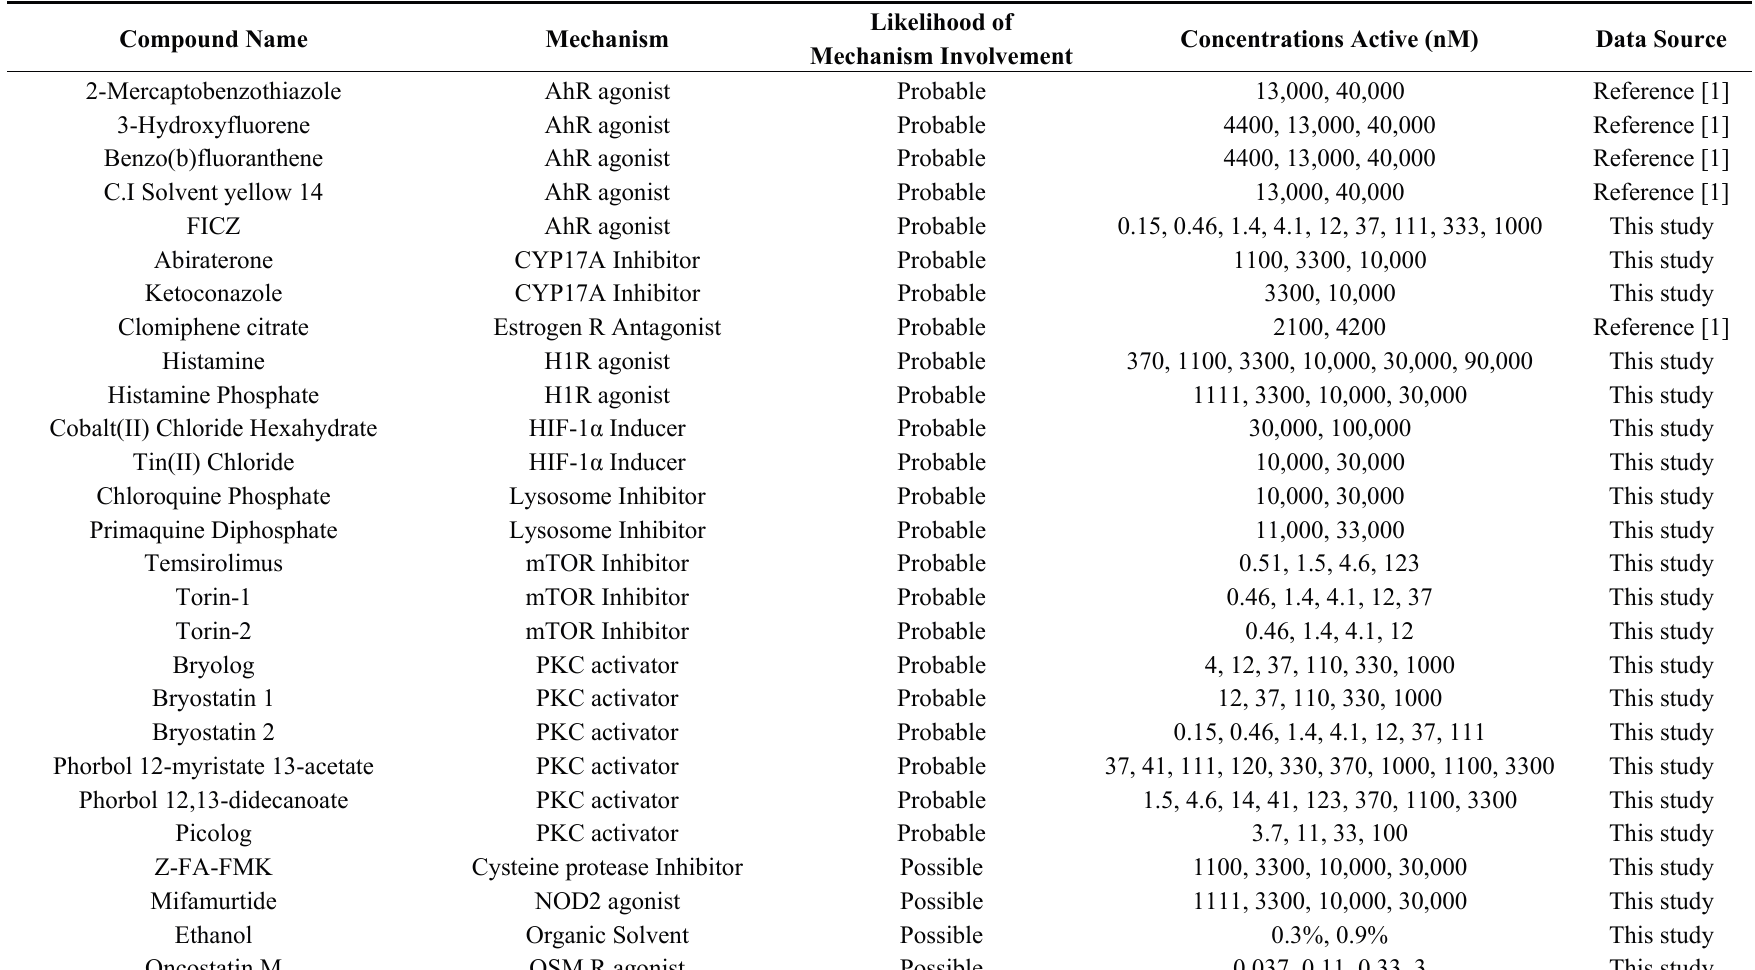
Table 1. List of test agents that increase cell surface levels of TF in the BioMAP 3C system, their mechanism class if known, the likelihood that the indicated mechanism class is involved in the regulation of TF (as described in the text), active concentrations (in nM unless otherwise listed) and the source of experimental data. Note that data for all compounds are included in Supplemental Table S3. Test agents listed increase TF >30% at two or more concentrations as described in the Experimental